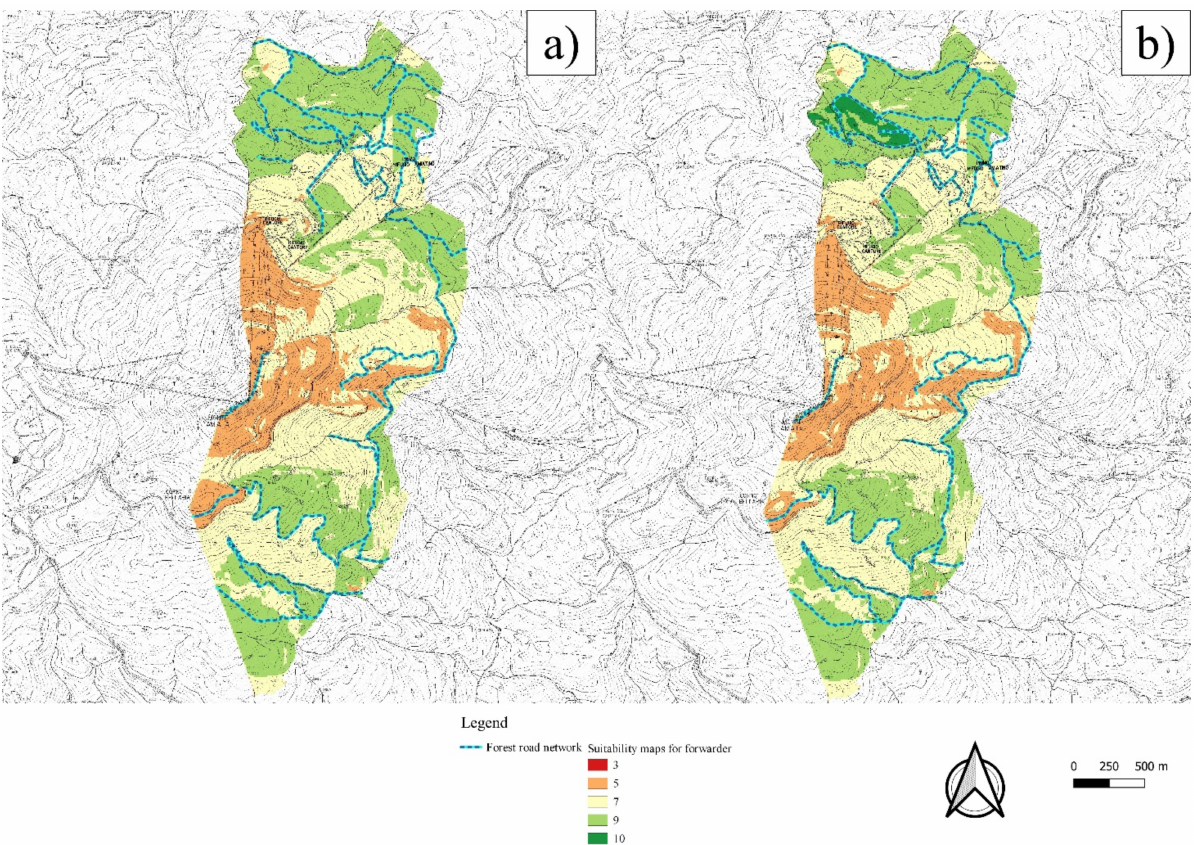
Figure 2. ( a ) Suitability map for forwarder, derived from the analysis with RTS input data. ( b ) Suitability map for forwarder, derived from the analysis with OS input